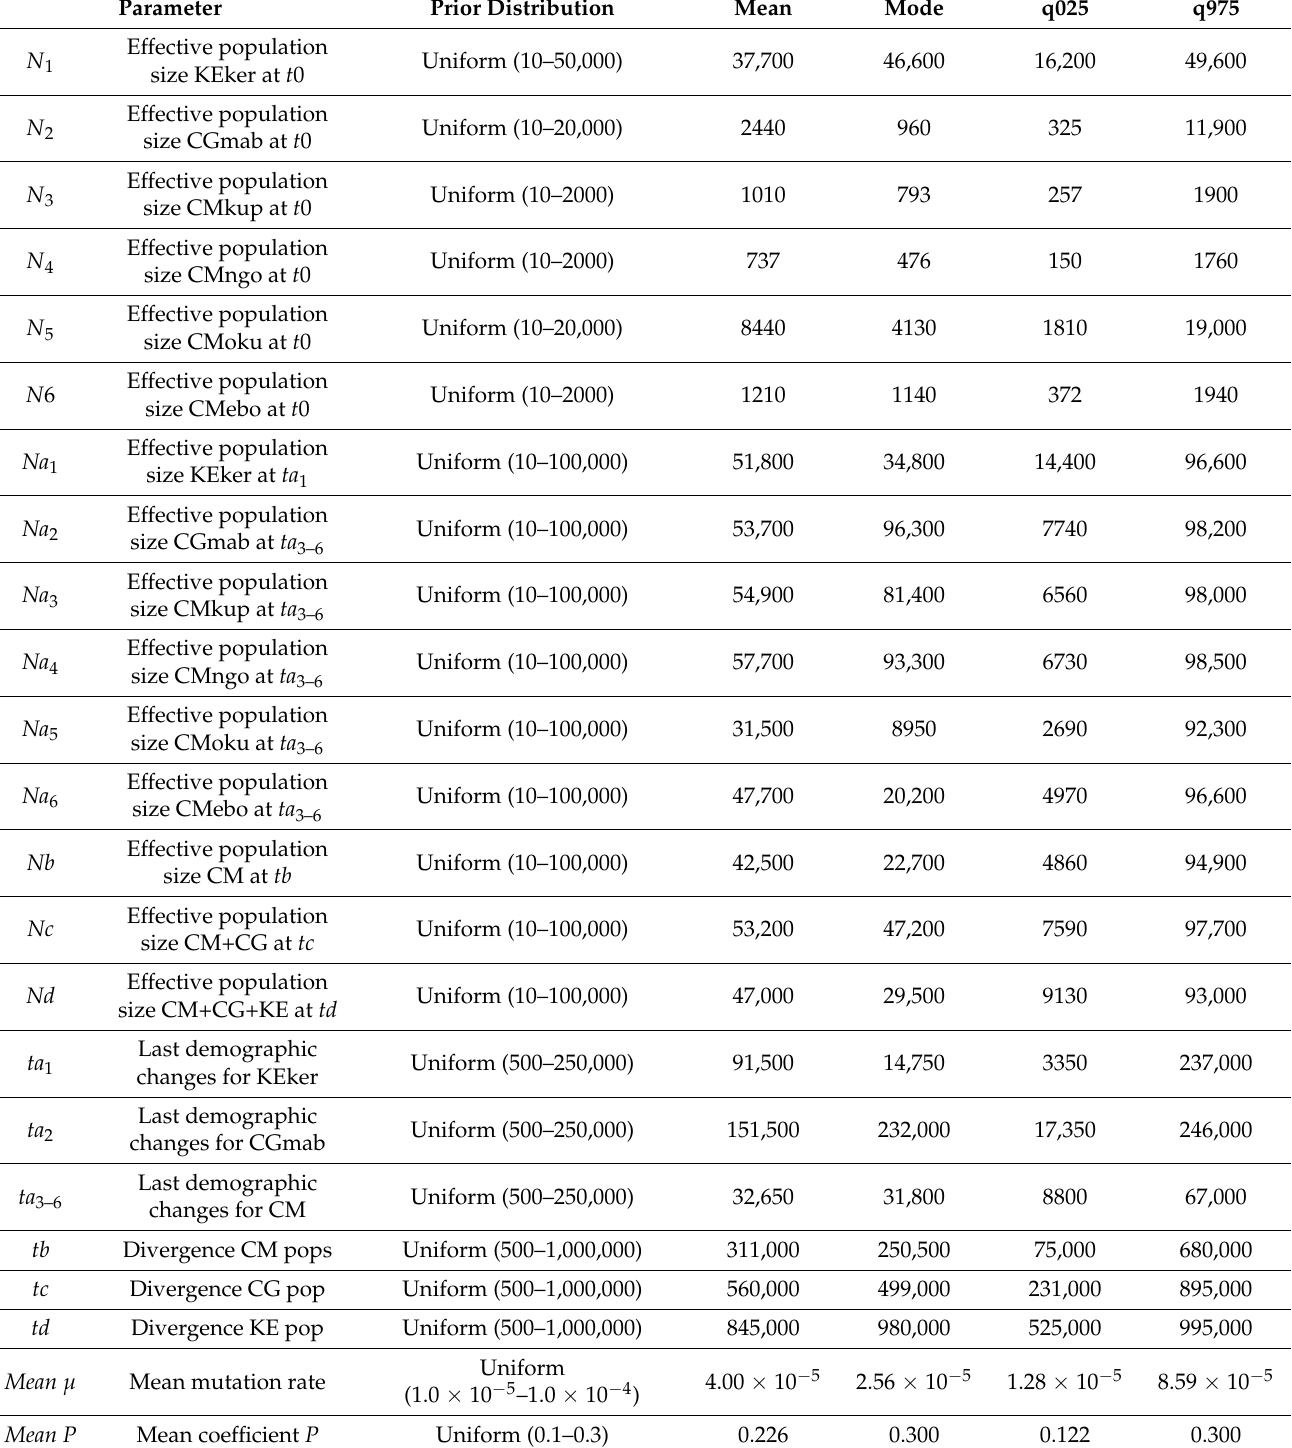
Table 3. Results of ABC demographic inference for P. latifolius : prior and posterior distributions of the demographic and historical parameters (graphical representation in Figure 4). Times in year BP and effective sizes in a number of